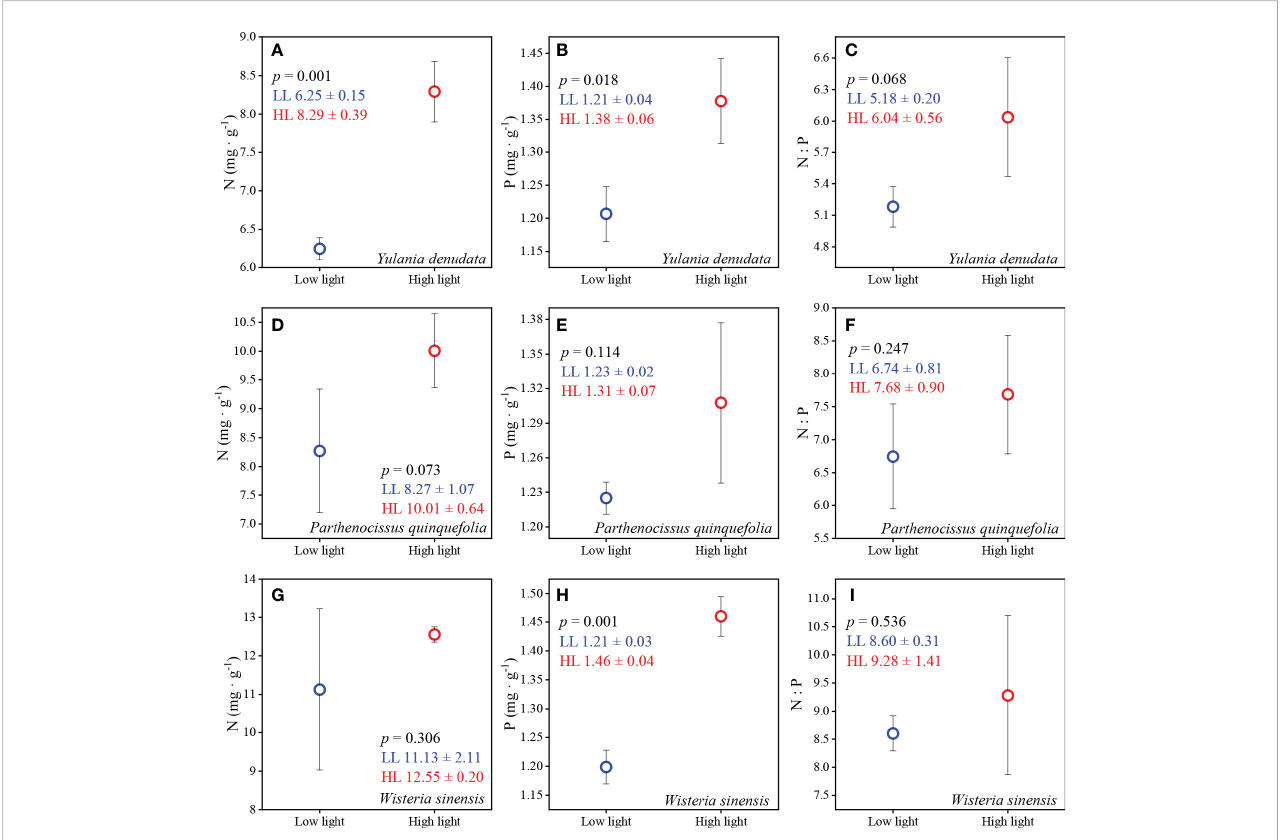
FIGURE 3 The N and P contents and N:P ratios under conditions of different light habitats. (A – C) represent the N, P content and N:P of Y. denudata leaves under different light habitats, respectively. (D – F) represent the N, P content and N:P of P. quinquefolia leaves under different light habitats, respectively. (G – I) represent the N, P content and N:P of W. sinensis leaves under different light habitats, respectively. The blue and red circles represent low light and high light, respectively. The numerical values in the fi gures represent the mean ± SD. p < 0.05 indicates a signi fi cant difference between the two light